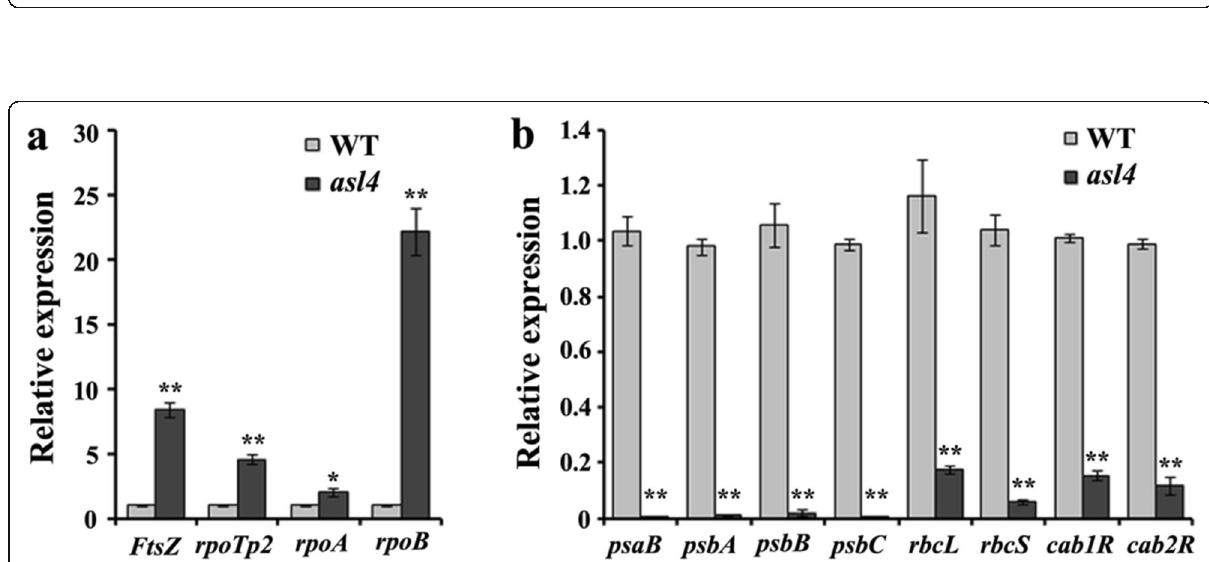
Fig. 5 Expression analysis of ASL4 . a Diagram of a L3 stage seedling when leaf 3 is fully expanded. SB indicates a 5 mm piece from the bottom of the shoot. L1-L4 represent leaves 1 to 4 in the L3 stage seedling. P0-P6 represent the developmental stages of leaf formation. b Expression of ASL4 in different wild-type sections at the L3 stage seedling from the paddy field. L4 – 2 cm, 4 cm, 6 cm and 8 cm indicate the length of the L4 leaf. c Expression levels of ASL4 in wild-type leaves at different stages. For example, L2 – 2 represent leaf 2 of a L2 stage seedling, L3 – 2 represent leaf 2 of a L3 stage seedling. d Expression analysis of ASL4 during light-induced greening of wild-type seedlings. Wild-type seedlings were exposed to light for 3, 6, 9, 12, 15, 18, 21 and 24 h after 10 days of growth in darkness at 30 °C. The ubiquitin gene was used as internal control. Values are means ± SD from three independent